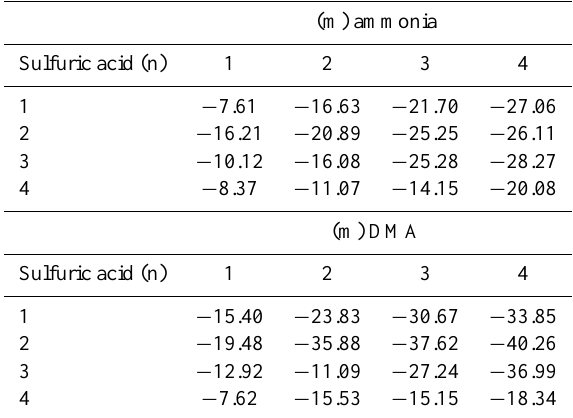
Table 3. Gibbs free energy for the reaction (H 2 SO 4 ) n − 1 (NH 3 /(CH 3 ) 2 NH) m + H 2 SO 4 → (H 2 SO 4 ) n (NH 3 /(CH 3 ) 2 NH) m ) in kcalmol − 1 at